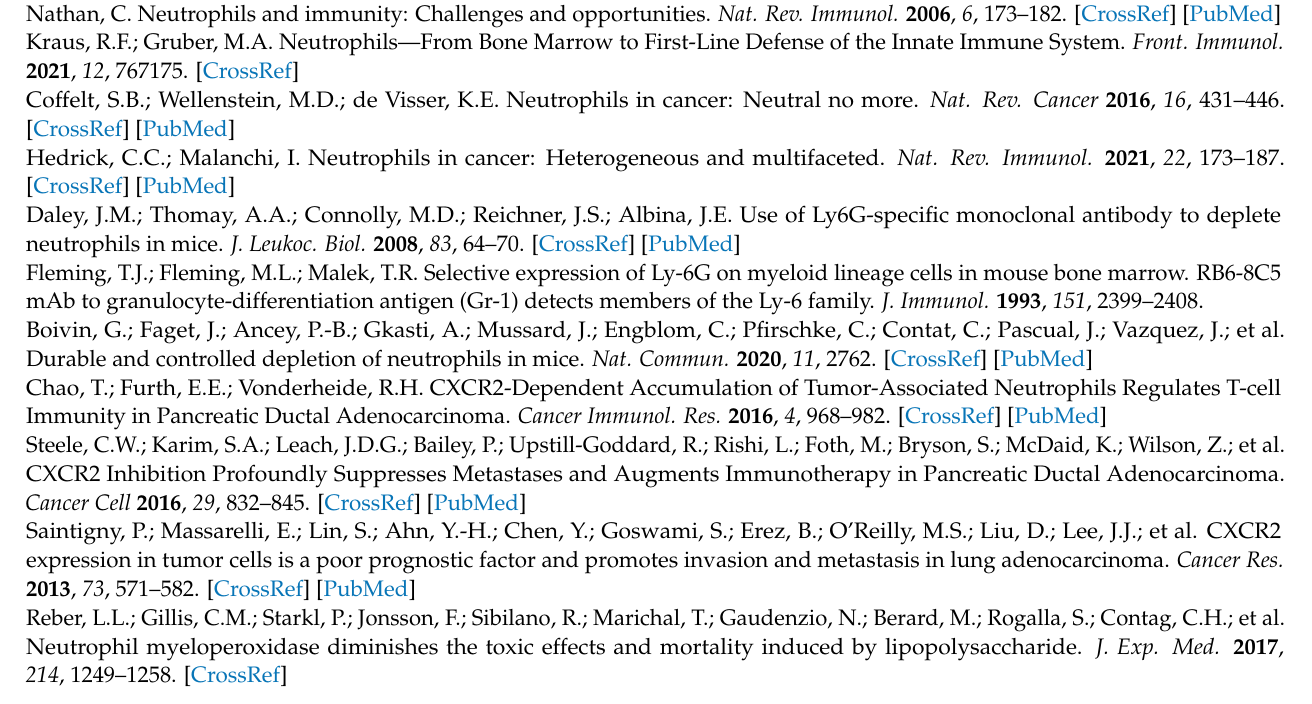
Figure S4: Flow cytometry gating strategy for lung and liver samples; Figure S5: Flow cytometry gating strategy for lymph node and bone marrow samples; Figure S6: Monocytes and eosinophils in the hMRP8-ATTAC model express low levels of the transgene; Figure S7: No reduction in monocyte and eosinophil frequencies upon dimerizer treatment in hMRP8-ATTAC mice; Figure S8: Dimerizer treatment has modest effects on neutrophils in WT mice; Figure S9: Flow cytometry gating strategy for tumor samples; Table S1: List of antibodies used for flow cytometry